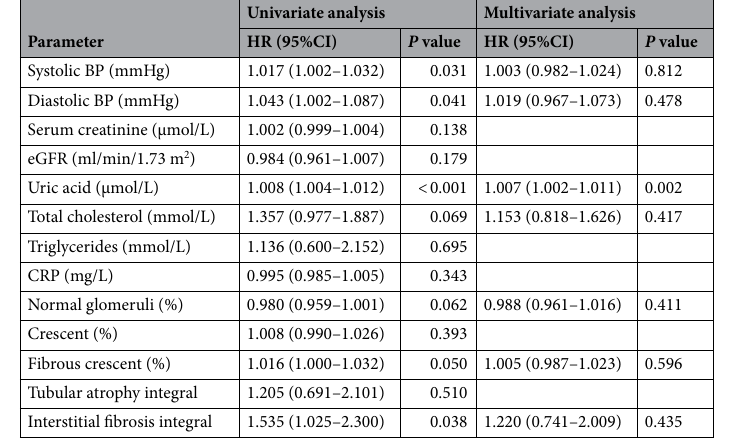
Table 4. Cox proportional hazard regression model describing long-term risk of death of ANCA-related renal vasculitis patients.